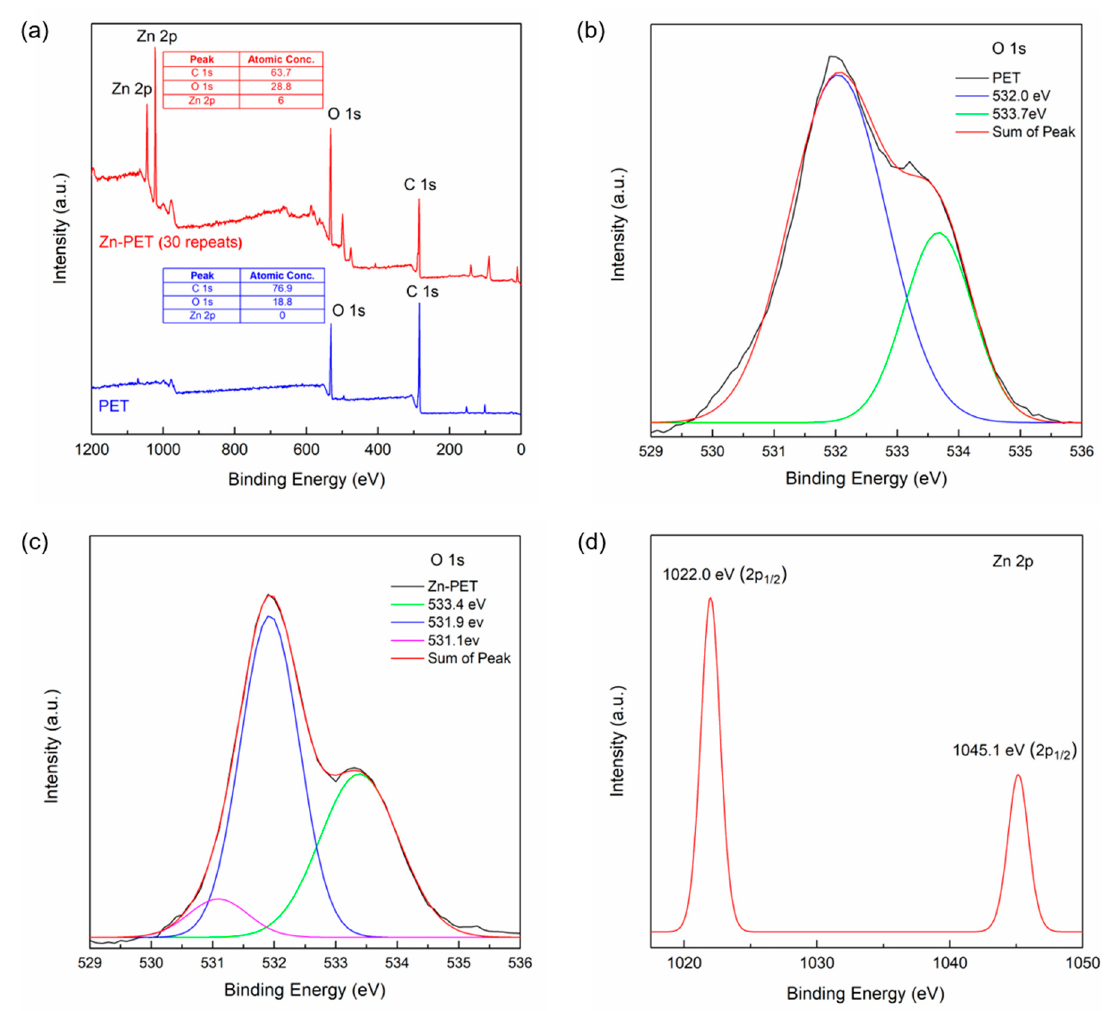
Figure 9. XPS survey spectra of PET and Zn-PET (30 repeats) ( a ), XPS spectra of O1s for PET ( b ) Zn-PET (30 repeats), and ( c ) films, and XPS spectra of Zn 2p 1/2 and 2p 3/2 ( d ).